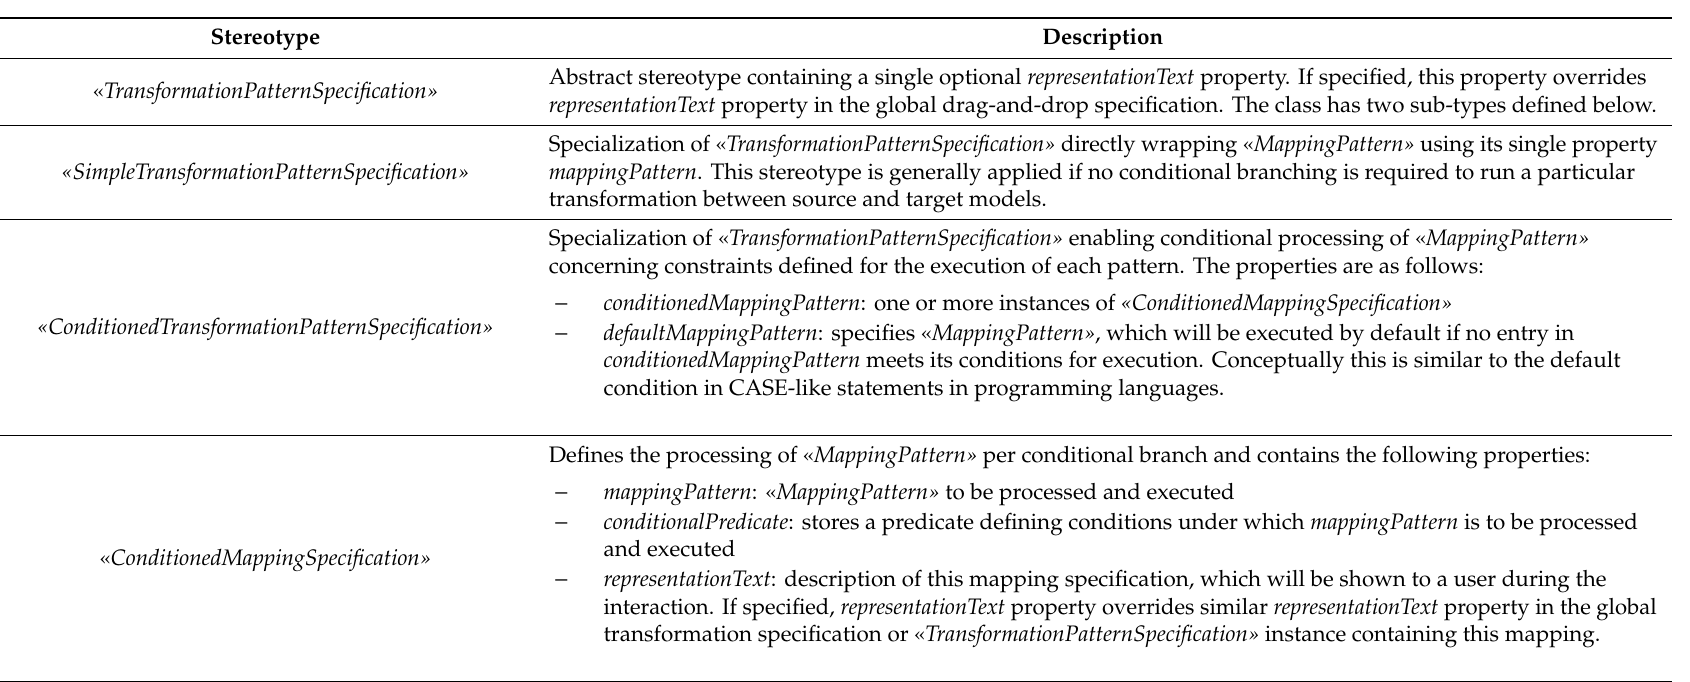
Table 1. Specification of elements extending the original metamodel